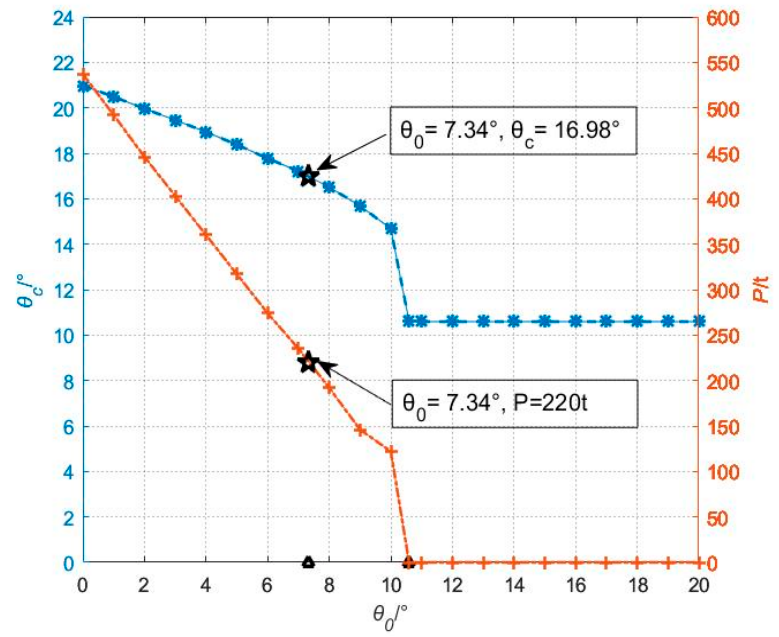
Figure 11. Critical heeling angle, θ c , and the corresponding firewater weight, P .